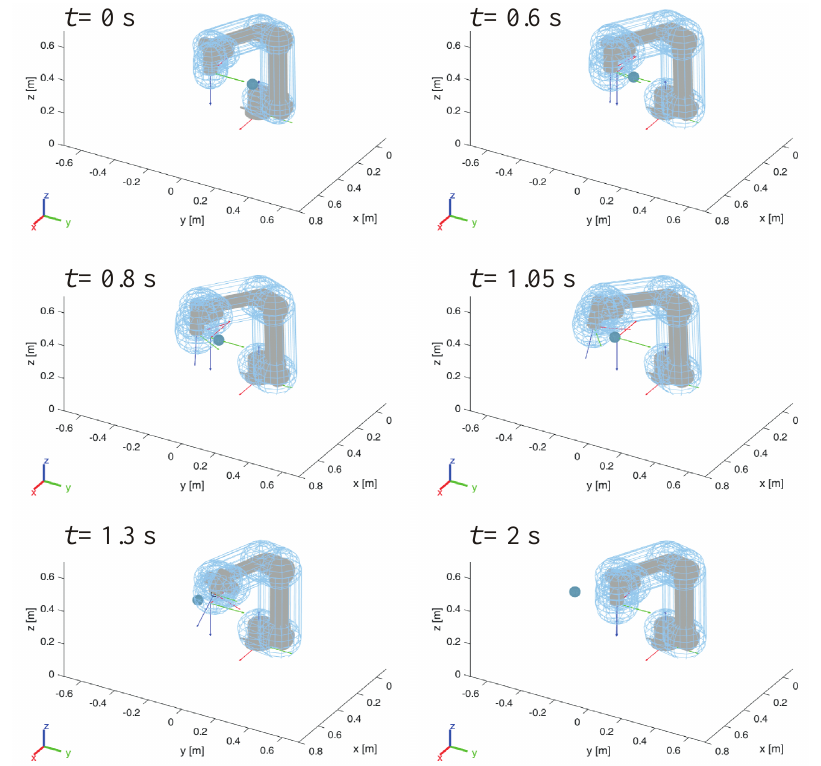
Figure 5. Avoidance of a moving obstacle interfering with the end-effector in a fixed position— mode I.